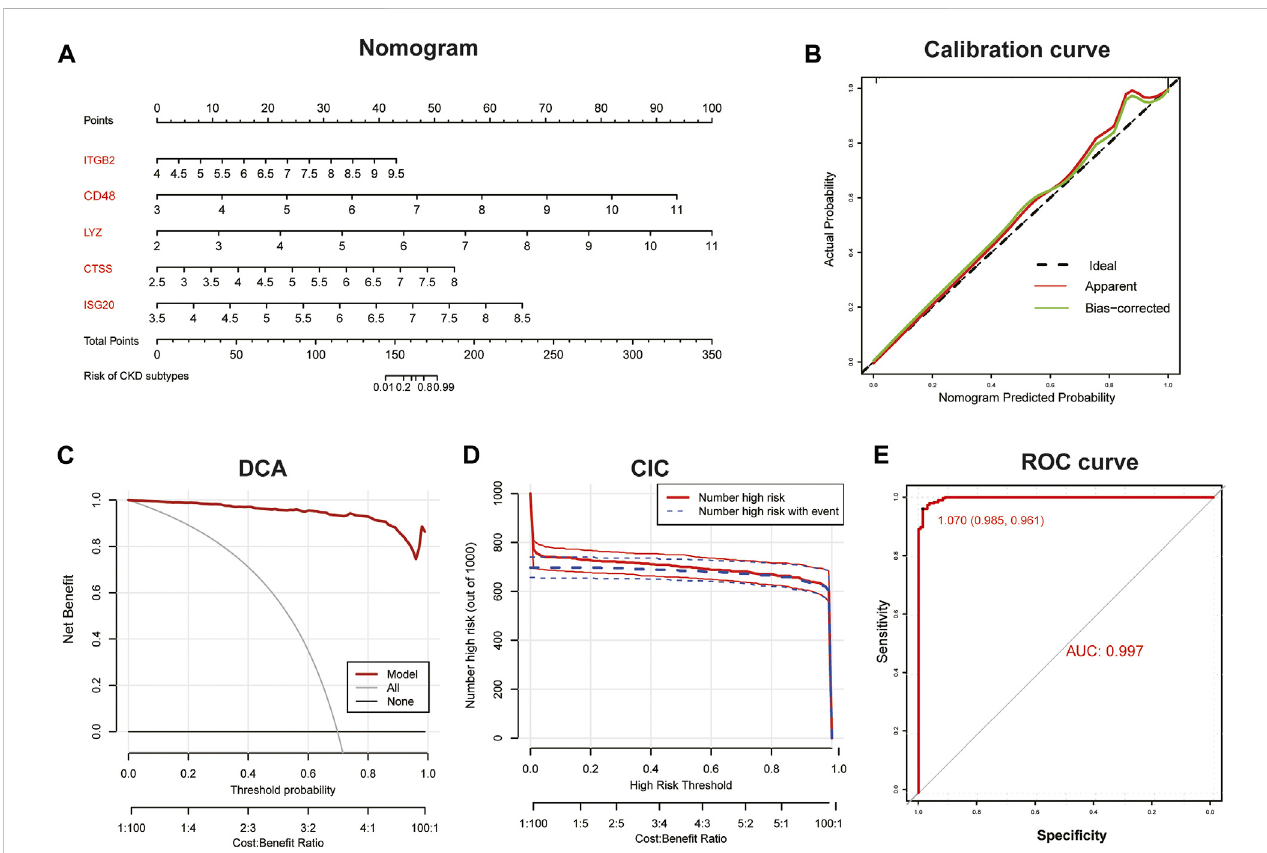
FIGURE 7 Construction of diagnostic Nomogram model. (A) Nomogram for predicting risk of CKD subtypes based on 5 key IRGs. (B, C) Calibration curve (B) and DCA (C) to estimate the predictive ef fi ciency of the Nomogram model. (D) Clinical impact curves (CIC) to estimate the clinical validity of Nomogram model based on DCA curve. (E) ROC curves to evaluate the discrimination